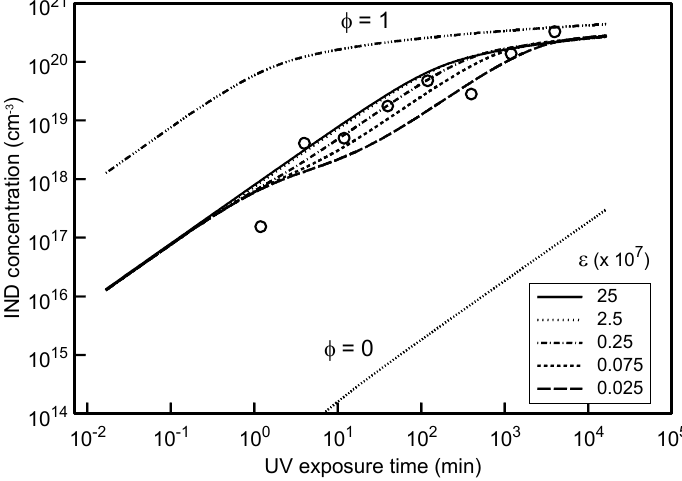
Figure 6. Variation of experimentally deduced IND trap concentrations with UV exposure period setting ( R l / C t ) = 5 × 10 18 cm − 3 . The solid curves show the expected dependence based upon the modeled DEH photo-oxidation dynamics for the ε values given. φ = 0.01 in all cases except for those